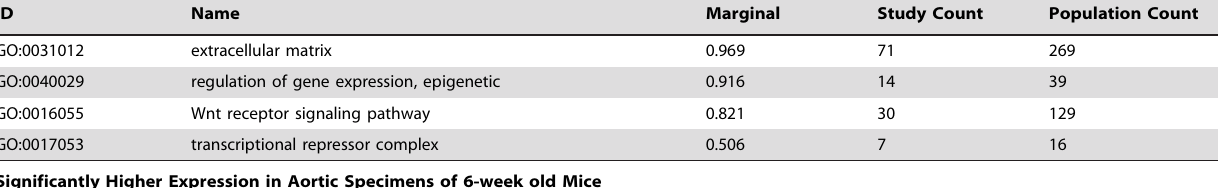
Table 1. GO model-based gene set analysis (MGSA) [25] using the Ontologizer [65].